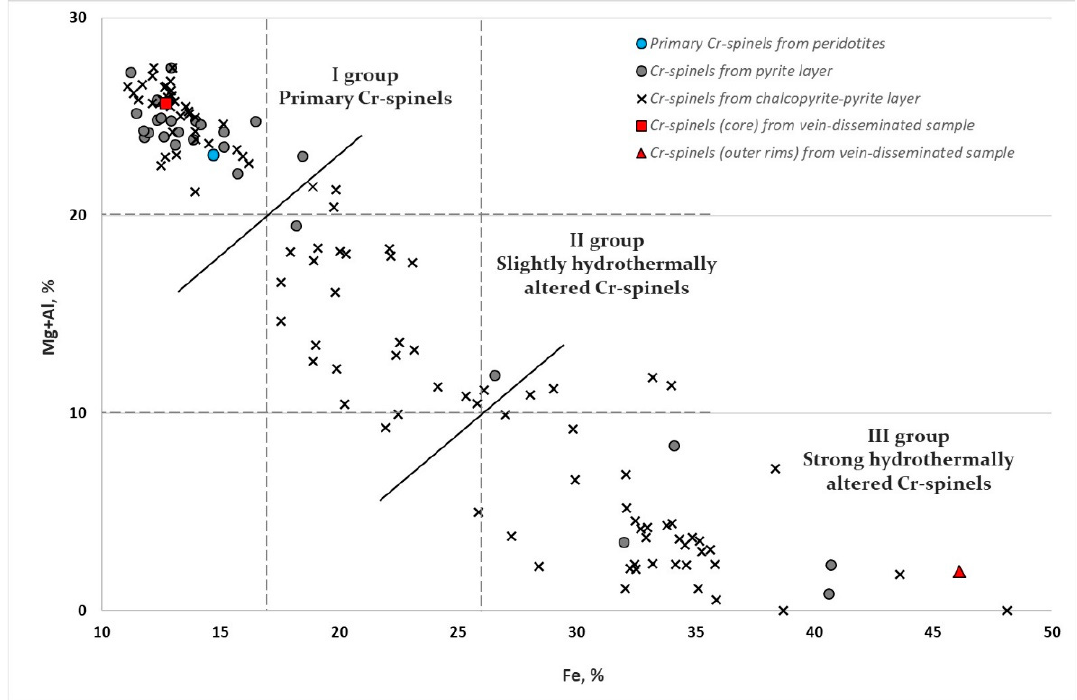
Figure 12. Variations of Cr ‐ spinels composition in axes Mg + Al and Fe. Group I (primary Cr ‐ spinels) Fe = 10–17 wt %, Mg + Al > 20 wt %, Cr/Fe > 2; group II (slight hydrothermally altered Cr ‐ spinels) Mg + Al = 10–20 wt %, Fe = 17–26 wt %, Cr/Fe = 1–2; group III (strong hydrothermally altered Cr ‐ spinels) Mg + Al < 10 wt %, Fe > 26 wt %, Cr/Fe < 1. The data of primary Cr ‐ spinels from peridotites (in blue) from [12,13].